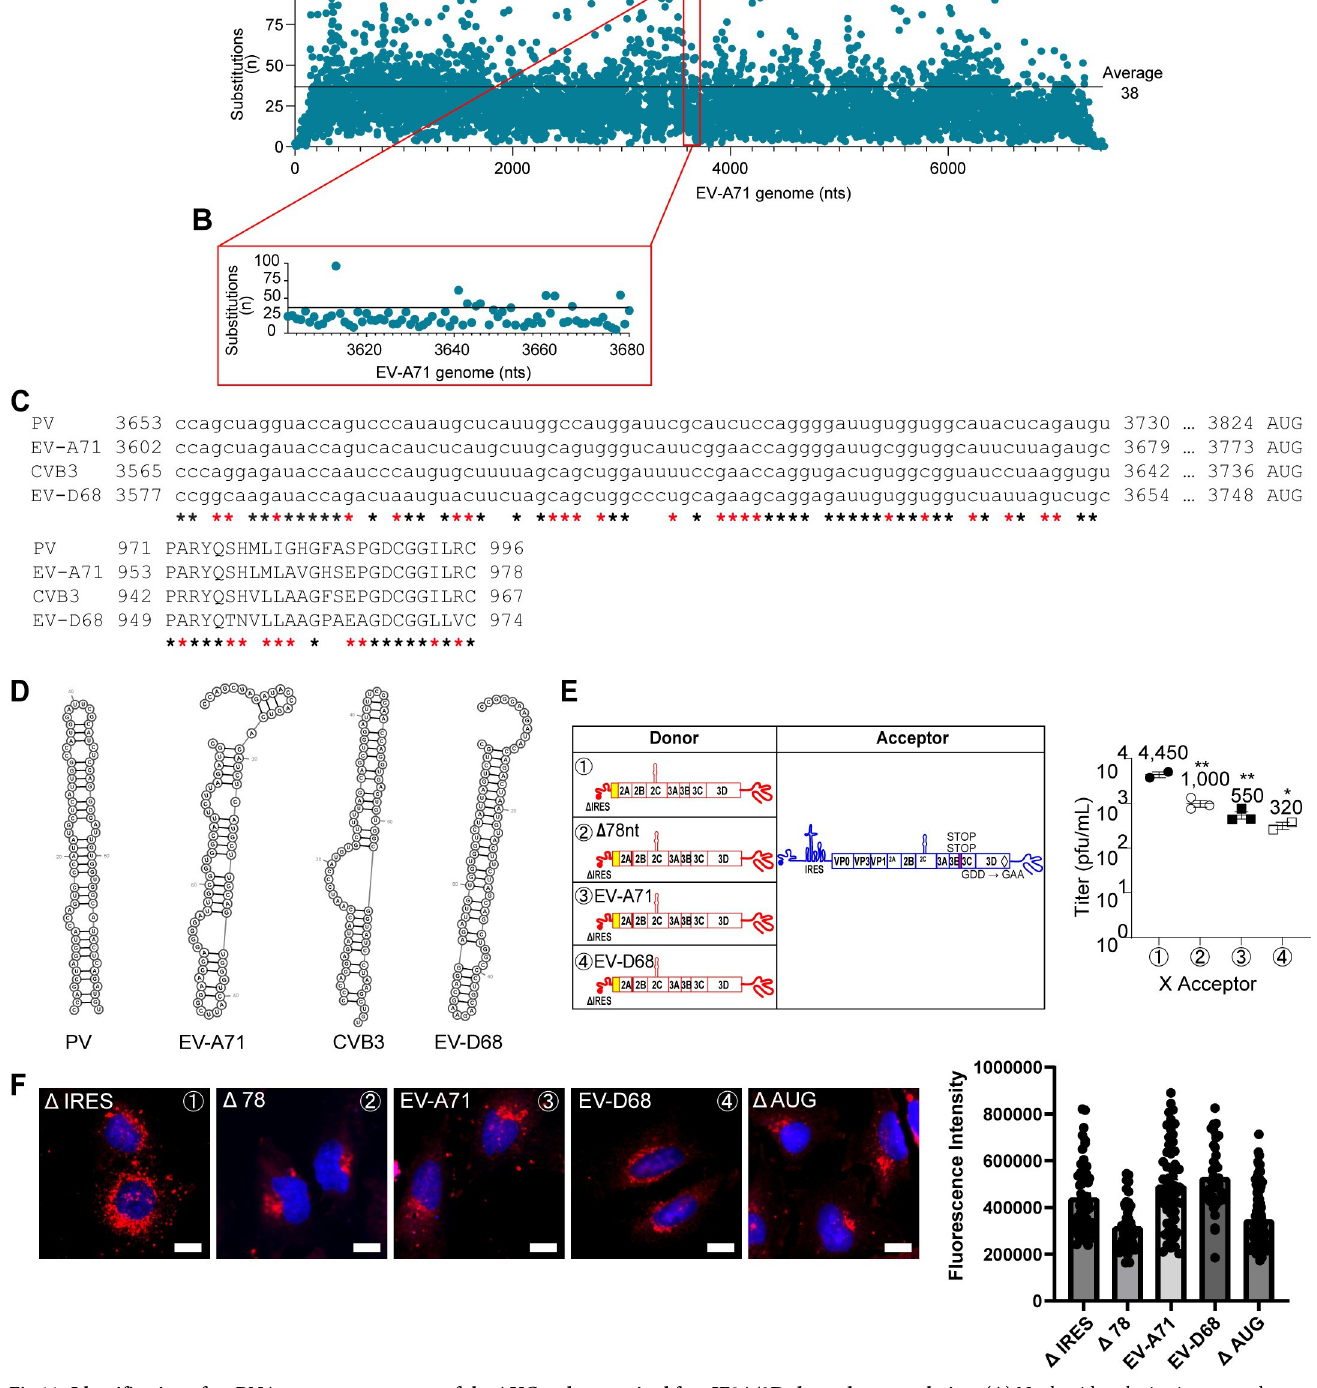
PLOS Biology | https://doi.org/10.1371/journal.pbio.3001693 January23, 2023 15 /